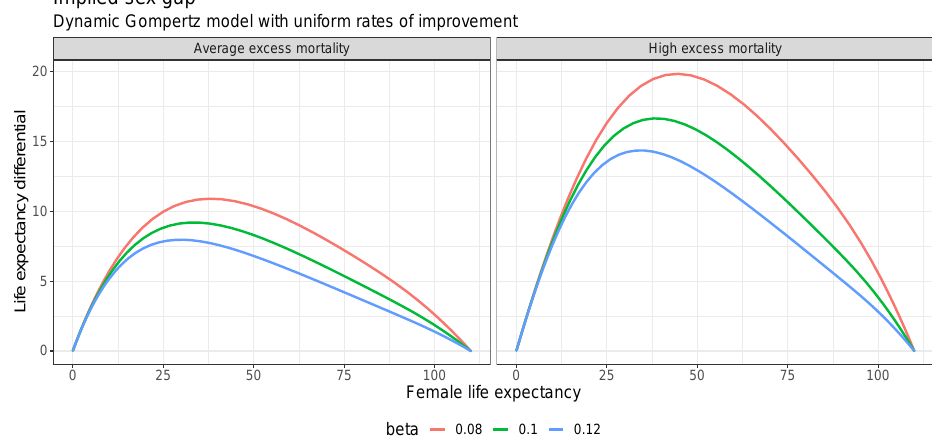
Figure 4. The sex gap trajectory implied by a dynamic Gompertz model for different values of the female slope parameter, β , for average and high excess male mortality. Left plot has ∆ α = 1.25 and ∆ = − 0.012, right plot has ∆ α = 2.2 and ∆ β